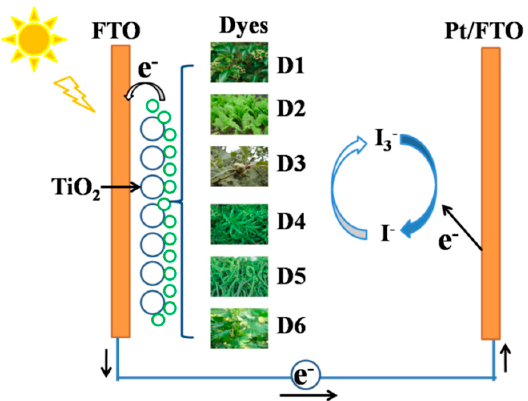
Figure 1. Basic working principle of DSSC, which mainly contains four parts: photoanode, natural dyes, electrolyte containing redox couple and counter electrode, where photosensitive layer using the dyes (D1–D6) were extracted from the leaves.